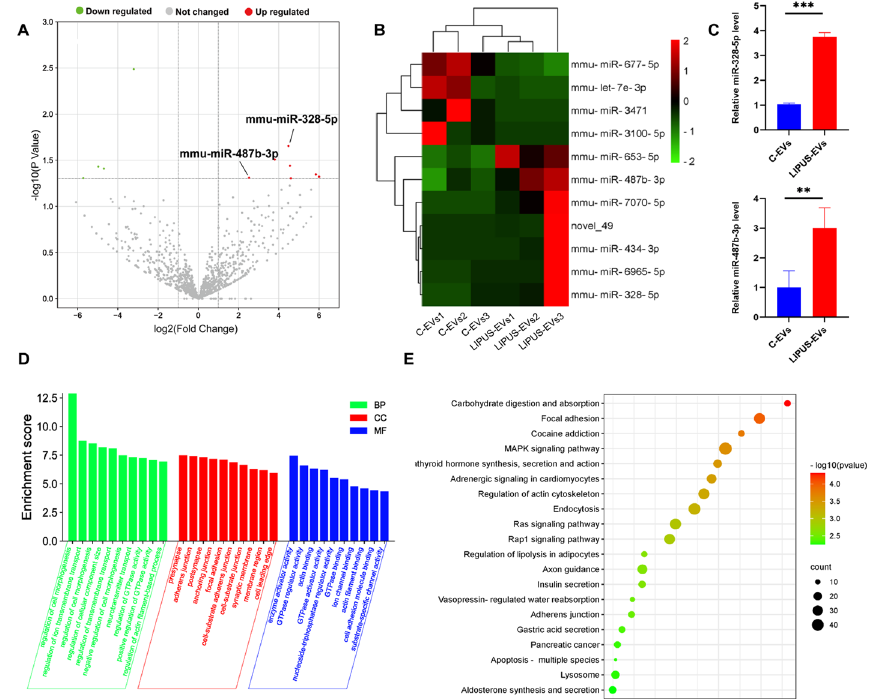
Fig. 5 Identification of differentially expressed miRNAs between C-EVs and LIPUS-EVs and functional analysis of DEmiRNAs using GO and KEGG pathway analyses. A Volcano map of DEmiRNAs between C-EVs and LIPUS-EVs. The x -axis is the log2 scale of the fold change of gene expression in C-EVs and LIPUS-EVs (log 2 (fold change)). Negative values indicate downregulation; positive values indicate upregulation. The y -axis is the minus log10 scale of the adjusted p values ( log10 ( P value)), which indicates the significant level of − expression difference. The red dots represent significantly upregulated genes with at least twofold change, while the green dots represent significantly downregulated genes with at least twofold change. B Heatmap of the differentially expressed genes between C-EVs and LIPUS-EVs. Red stripes in the figure represent high expression genes, while green stripes represent low expression genes. C qRT-PCR analysis of miR-328-5p and miR-487b-3p. n 3 per group. *** p < 0.001, ** p < 0.01. D Significant enriched GO terms between C-EVs and = LIPUS-EVs based on their functions. E Top 20 KEGG pathways enriched in target genes of DEmiRNAs. The x -axis indicates the ratio of the number of genes in the DEmiRNAs, and the y -axis indicates the pathways. EVs extracellular